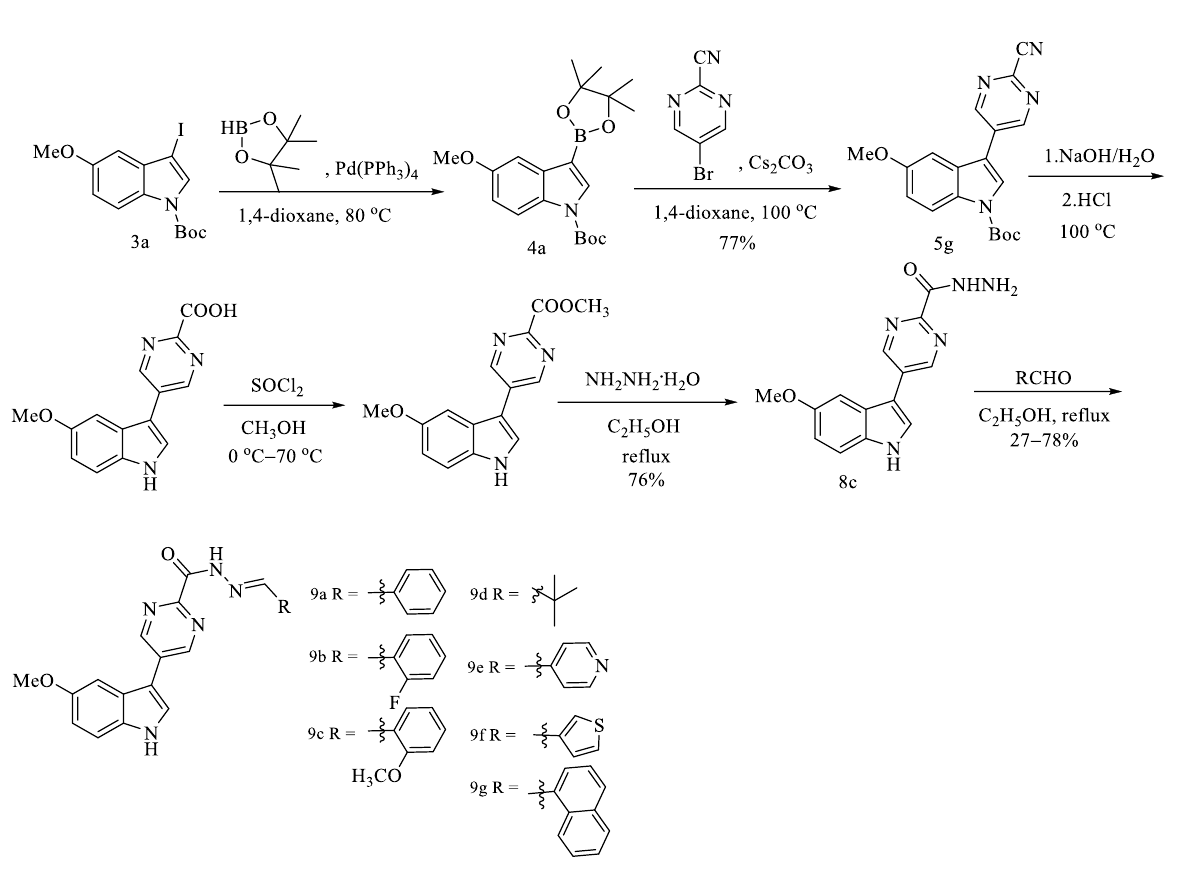
Table 1. In vivo antiviral activities of ningnanmycin, ribavirin, and c ompounds 5a−5d, 6a−6e, 7a−7f, 8a−8b , and 9a−9g against TMV .